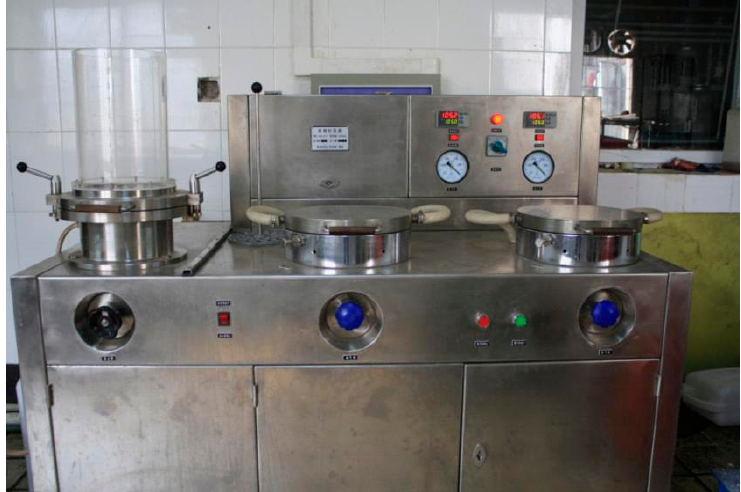
Figure 1. ZQJ1-B-II pattern shaper.